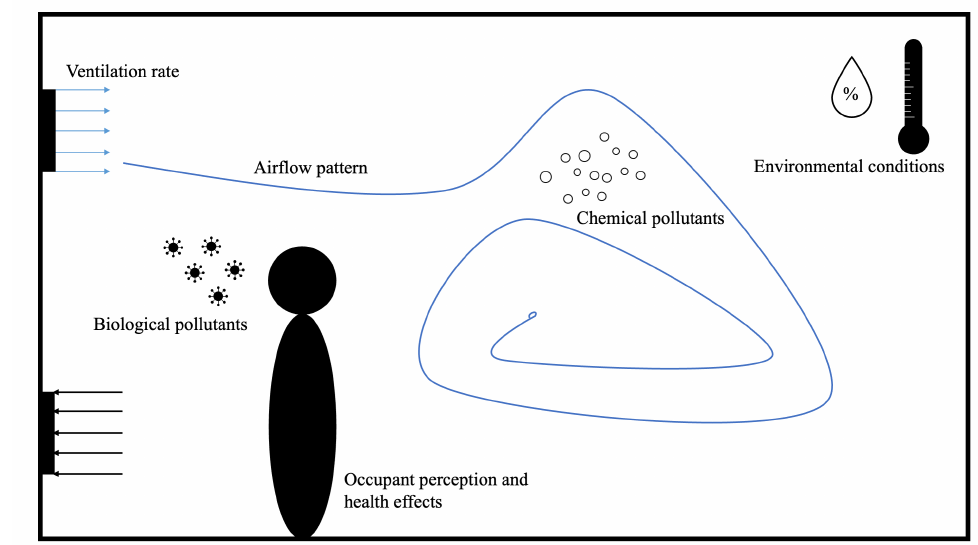
Figure 3. Airscape—IAQ indicators presented